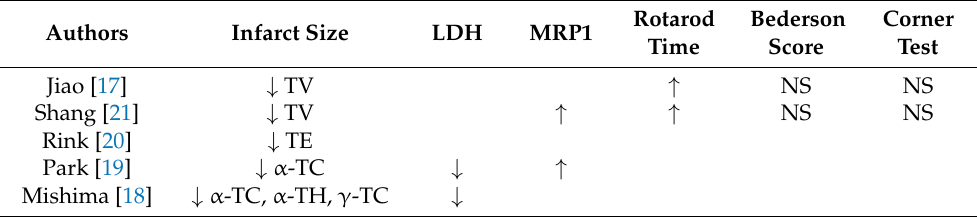
Table 2. Outcomes of the tocotrienol treatment in cerebral ischemia-reperfusion injury.